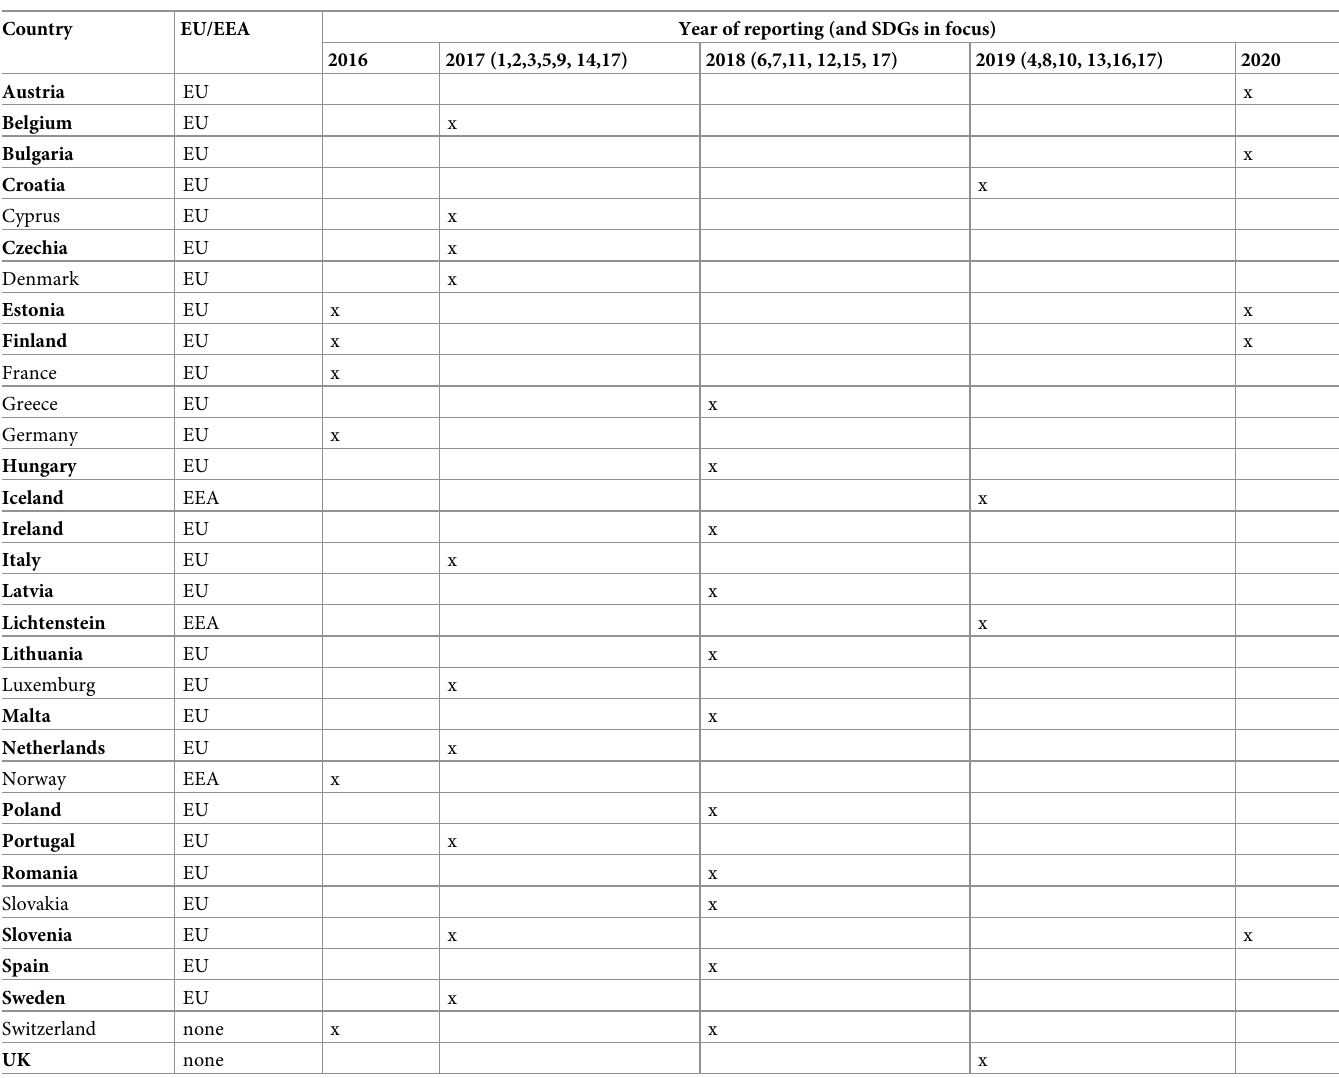
Overview of countries and their membership in EU/EEA and the years of reporting to HLPF; Bold –alcohol indicated in the report (regardless of the level of